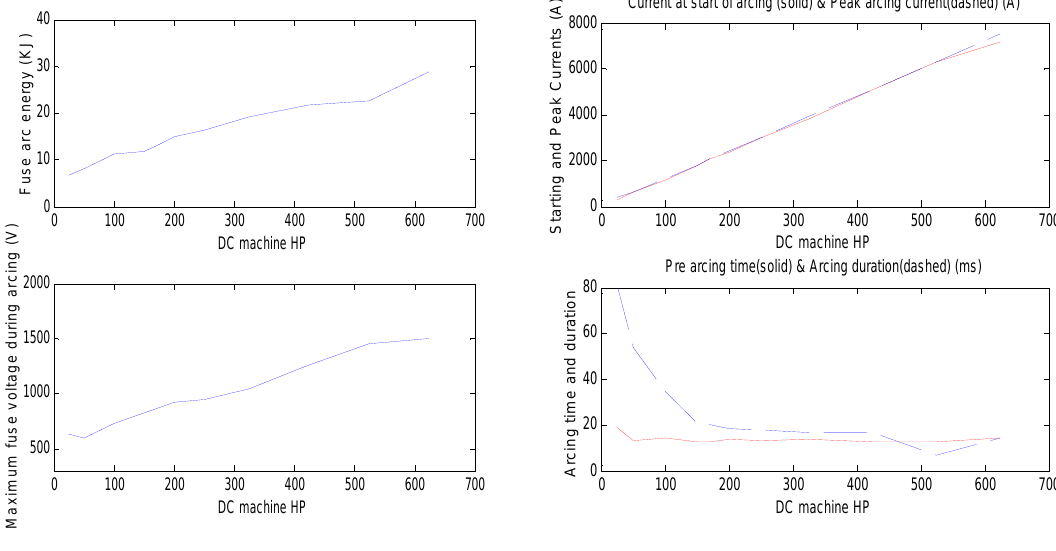
Figure 10. Variation of the arc energy (kJ) and fuse voltage (V), current at start of arcing (A), peak arcing current (A), pre arcing time(ms) and arcing duration (ms) versus the DC machine HP when 200 A fuse used as F1.